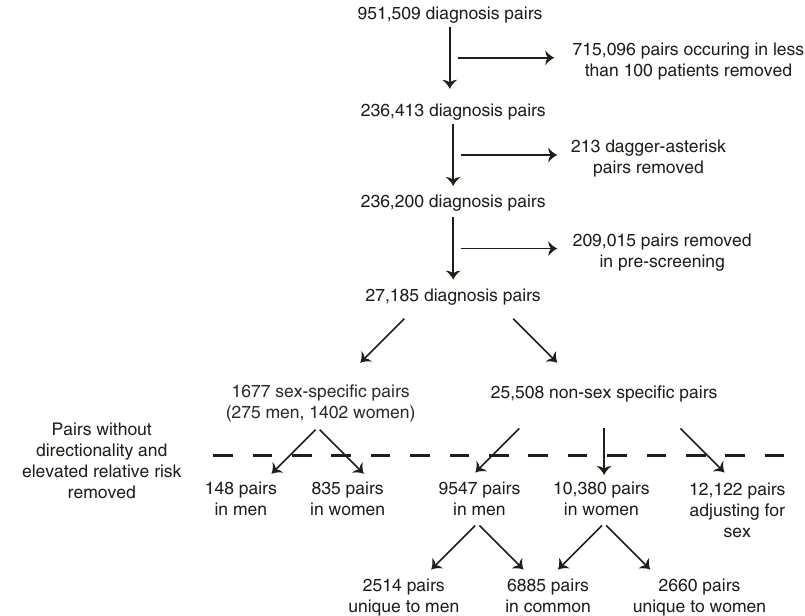
Fig. 2 Diagnosis co-occurrences found in population-wide data from 6,909,676 patients. 951,509 ICD-10 level 3 diagnosis pairs were found to occur in the population; of these, a large number were fi ltered out due to low frequency ( N < 100), dagger − asterisk combinations, or due to not passing the crude estimate of the relative risk. The standard method for calculating a con fi dence interval was applied in the prescreening section. Post- fi ltering 27,185 diagnosis pairs remained comprising 1360 unique diagnoses. Of these, 275 pairs involved a male-speci fi c diagnosis and 1402 a female-speci fi c